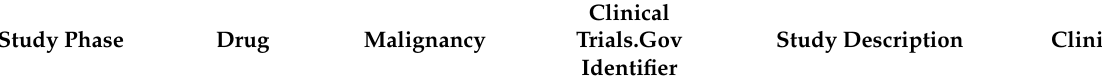
Table 2. Completed clinical trials on LSD1 inhibitors for breast